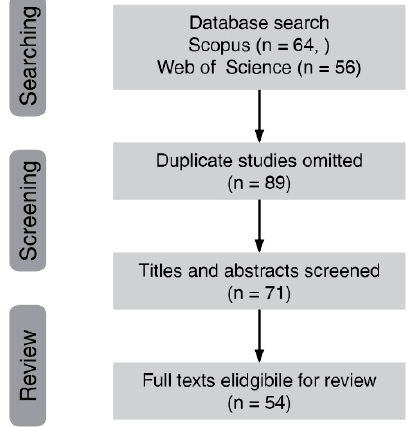
Figure 1. Scheme over search and filtering process. Starting from search of two databases for publications between 2000 and mid-2016 to screening and filtering before final review. From 120 articles in the initial search, the final number of articles included was 54.